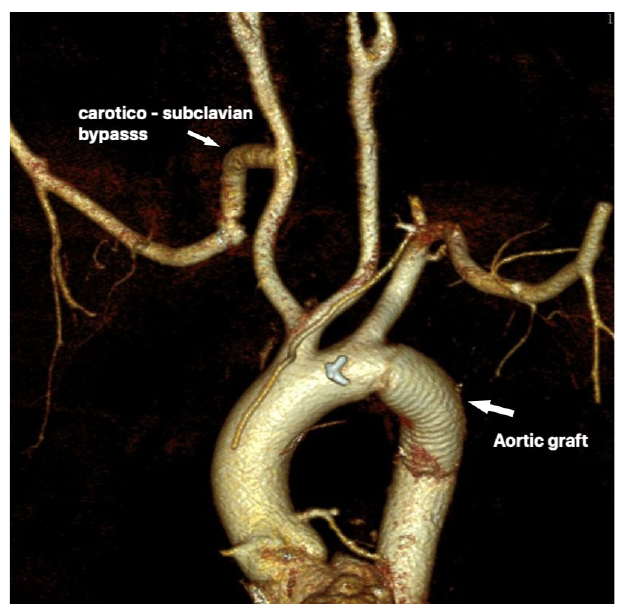
Fig. 1 - Postoperative control three-dimensional reconstructed computed tomography angiography of thoracic endovascular aortic repair (TEVAR) and bilateral carotid-subclavian artery bypass.